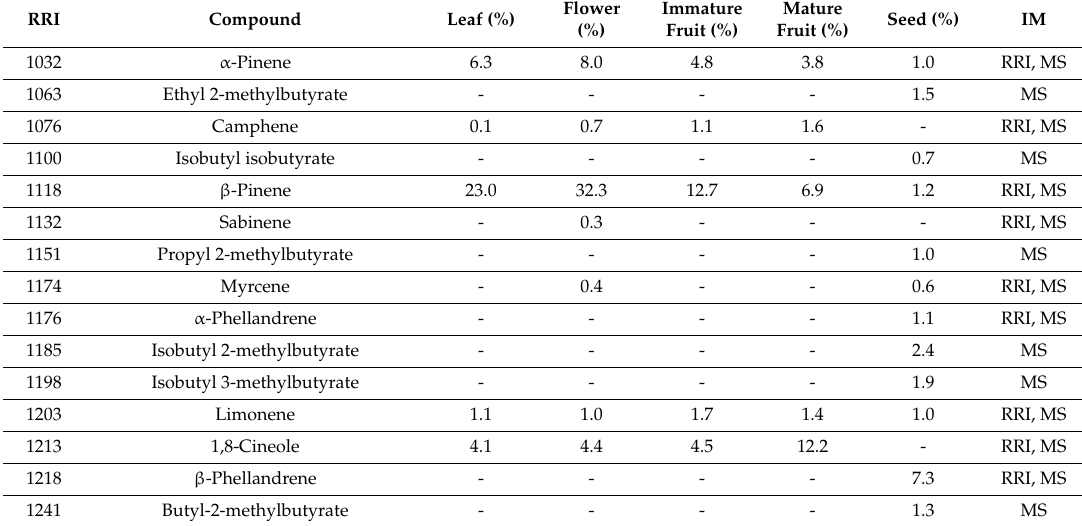
Table 1. The chemical composition of essential oils of the Magnolia